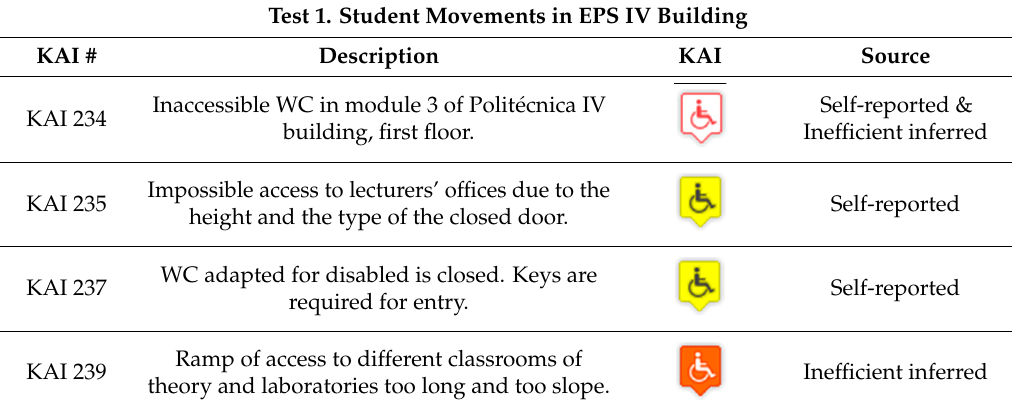
Table 3. Different KAIs obtained in the validation process in Politécnica IV building.